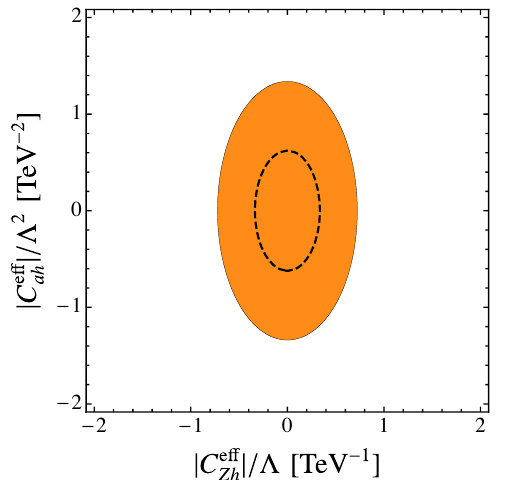
and C e(cid:11) obtained from the present Zh ah BSM) < 0 : 1, as expected !